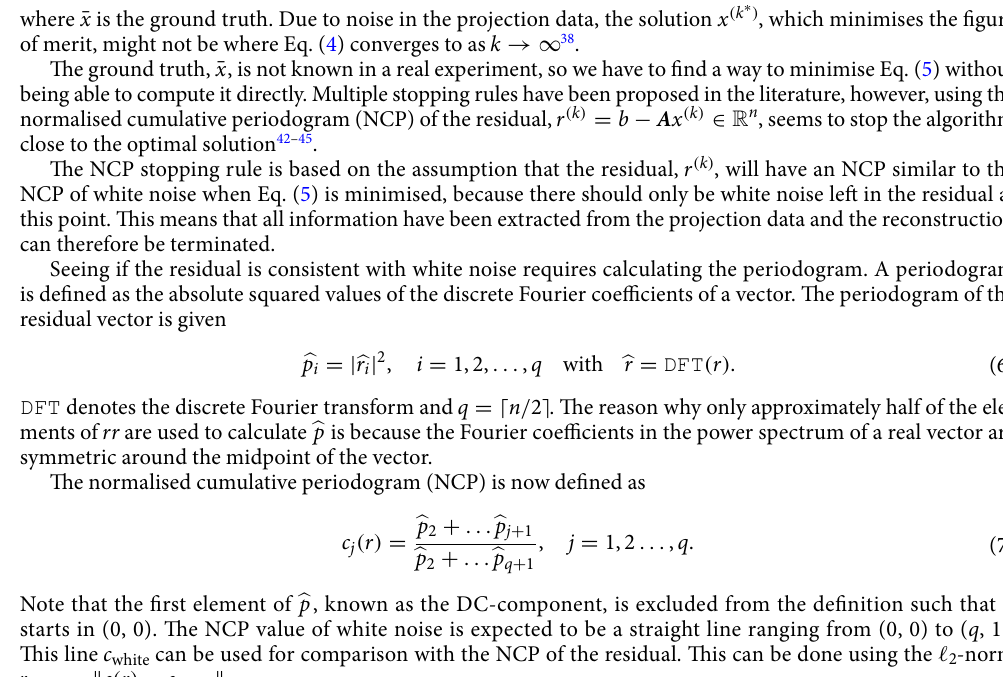
(5) Figure of merit = � x ( k ) − ¯ x � 2